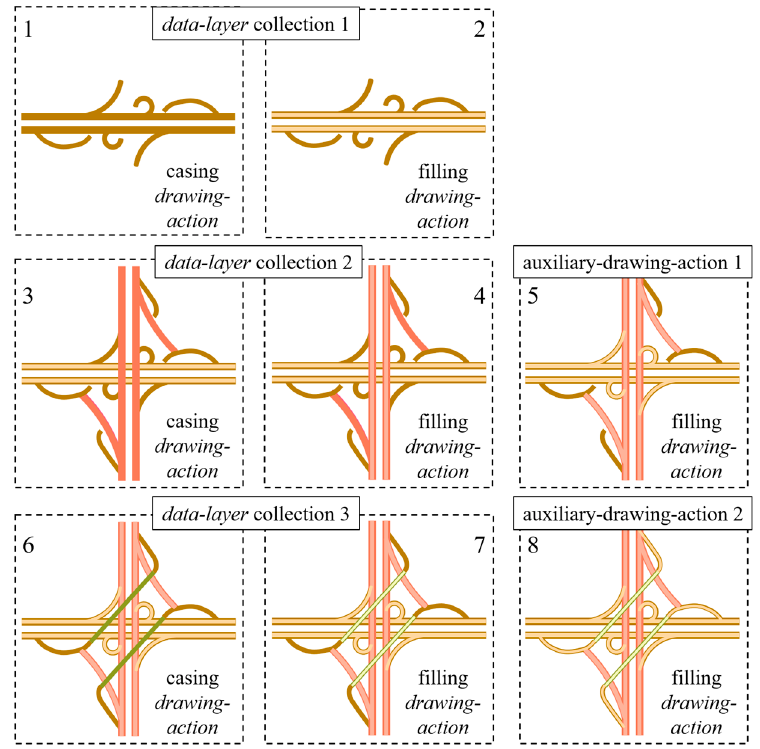
Figure 14. Rendering sequence for road networks with three levels.